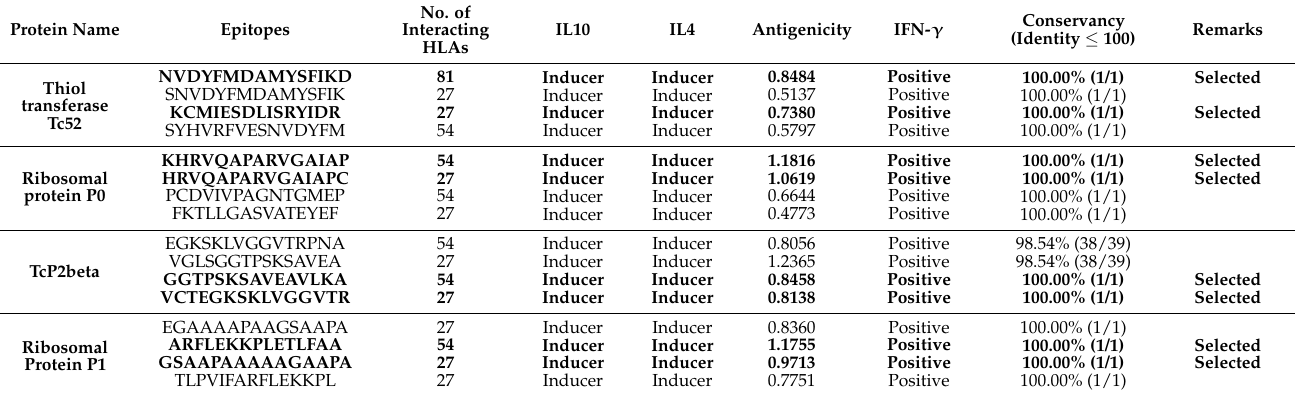
Table 3. Final HTL